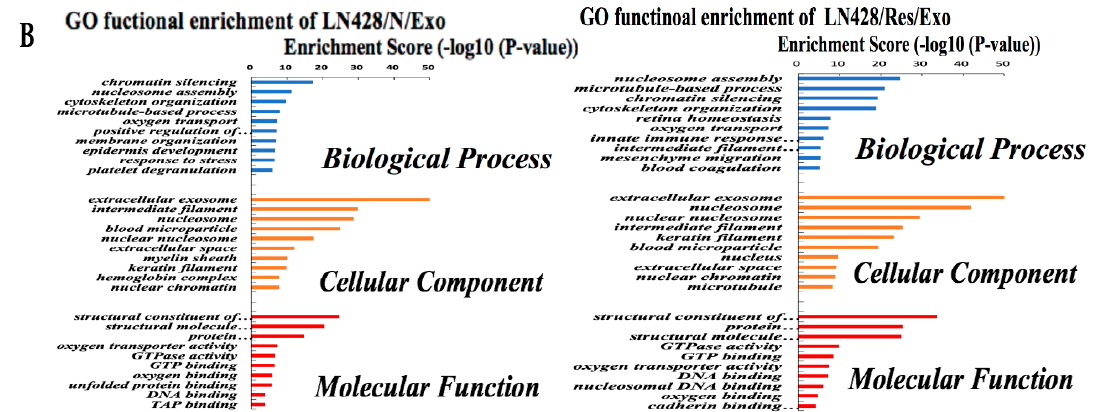
Figure 5. The identified proteins in U251- and LN428-derived exosomes were analyzed by gene ontology enrichment (GO) ( A , B ) in terms of biological process, cellular component, and molecular function annotation.